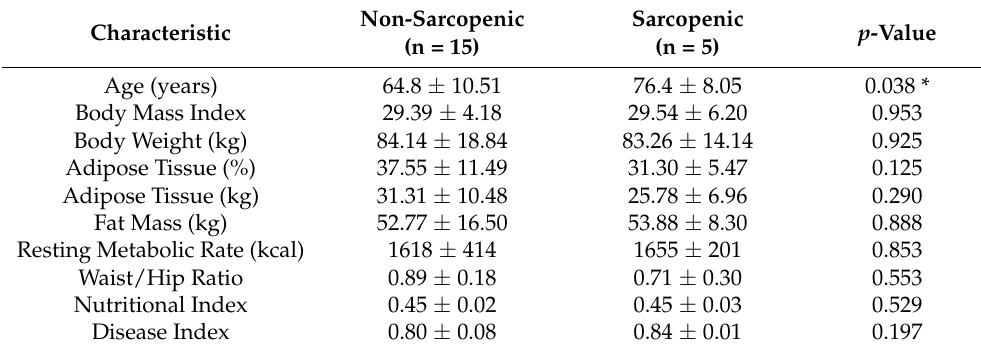
Table 1. Characteristics of sarcopenic vs. non-sarcopenic patients and differences between two